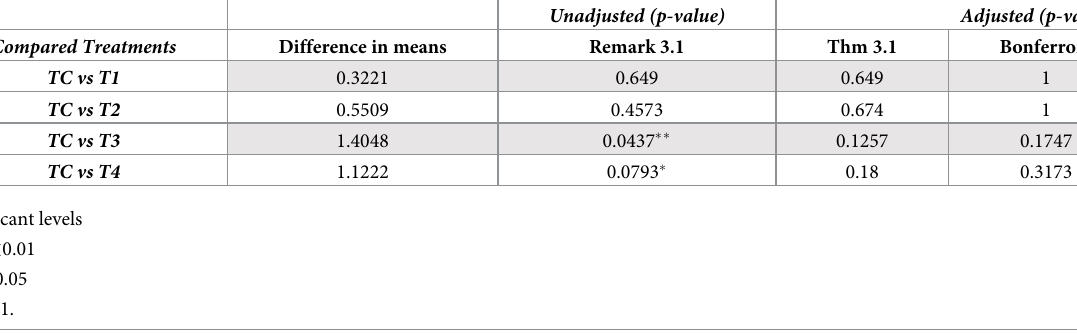
Table 6. Multiple hypothesis testing (MHT) of average donations (comparison between the control and emotion treatments). Compared